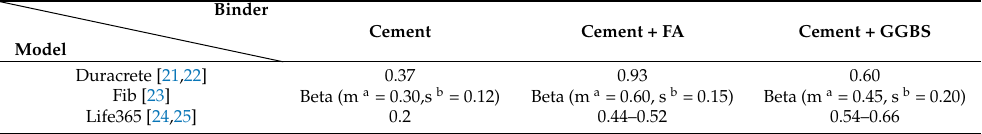
Table 6. The Age Factor of Chloride Diffusion Coefficient.